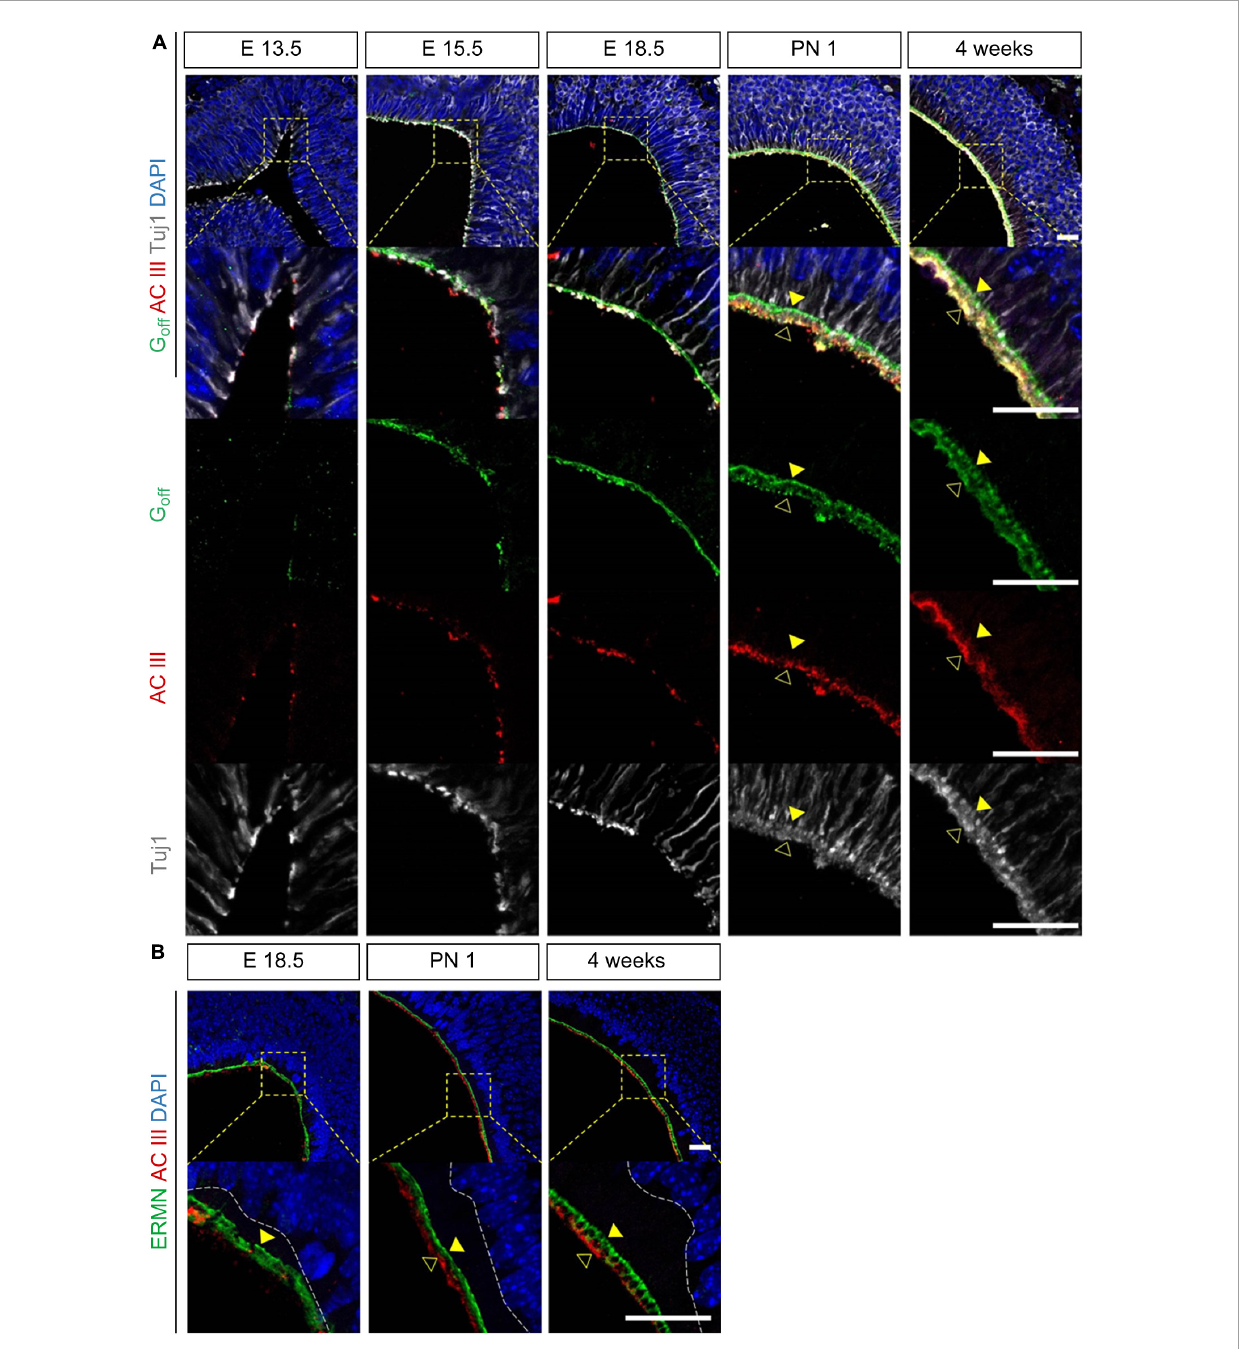
FIGURE3 Molecular changes during the development of olfactory cilia. All images were obtained in the coronal direction. (A) Immunostaining with anti-G olf , anti-ACIII antibody, anti-Tuj1 antibody, and DAPI at E13.5, E15.5, E18.5, PN 1, and 1 week in the coronal direction. (B) Immunostaining with anti-ERMN, anti-ACIII antibody, and DAPI at E18.5, PN 1, and 4 weeks. Yellow solid arrows in panel (A) indicate Golf + and ACIII + cilia and yellow hollow arrows indicate only ACIII + cilia. Yellow solid arrows in panel (B) indicate ERMN + cilia. Scale bar, 20 µ